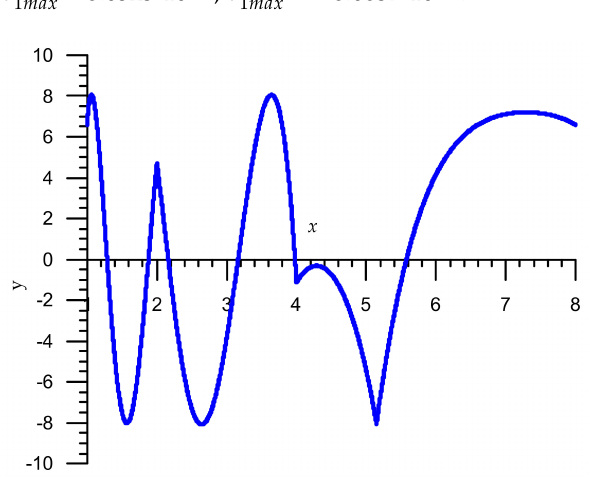
Figure 3. The first iteration relative error graphs Algorithm 3 for the interval x ∈